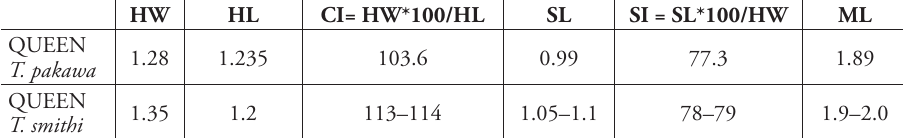
Table 3. Dimensions (mm) of morphological features of the queen caste of Trachymyrmex pakawa (n = 1) and Trachymyrmex